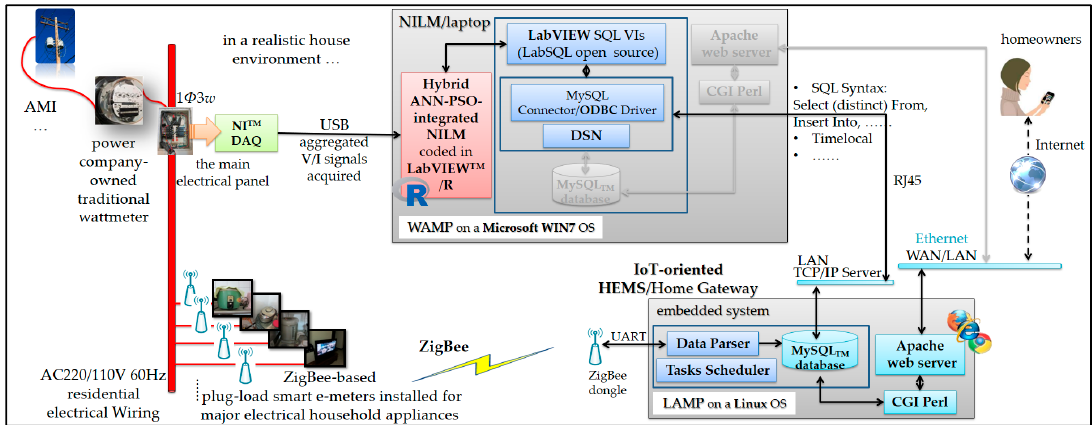
Figure 1. Block diagram of the proposed central Internet of Things (IoT)-oriented Home Energy Management System (HEMS) utilizing the novel hybrid Artificial Neural Network (ANN)-Particle Swarm Optimization (PSO)-integrated Non-Intrusive Load Monitoring (NILM) proposed in this paper and deployed in a realistic residential environment for Demand-Side Management (DSM) as a load classification task.